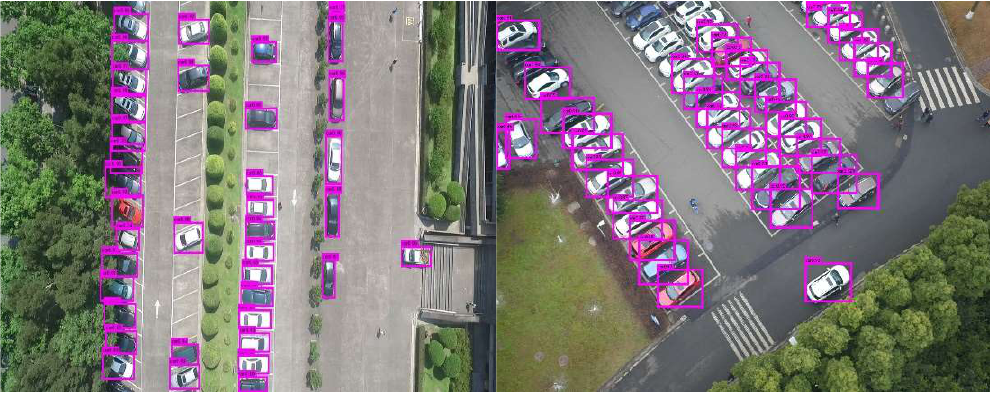
Figure 2. Test results of the YOLOv3 network at 4000 iterations, which contain a large amount of missed targets. Table 1. Test AP (Average Precision) values of the YOLOv3 network at different training iterations.